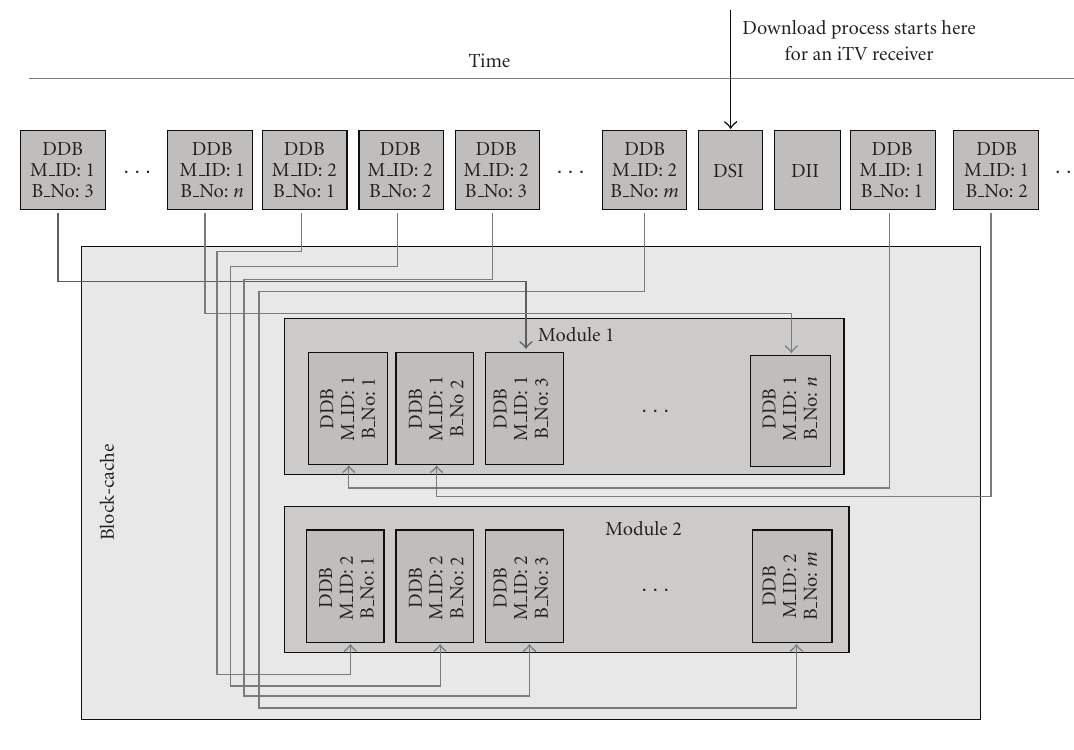
Figure 11: A received sequence of DSM-CC commands and the block